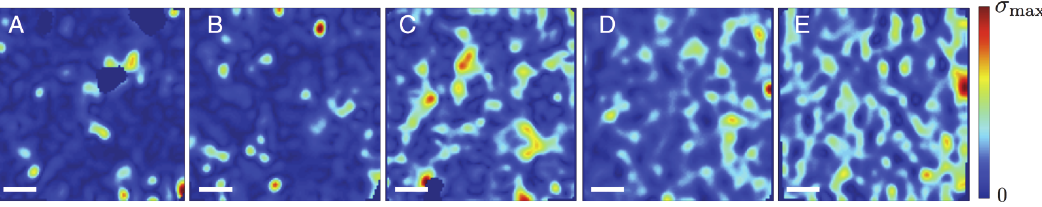
= g L ¼ 1 : 5 for concentrations c = {0.25, 0.50, 0.75, 1.0, 1.5} mg/mL, L 0